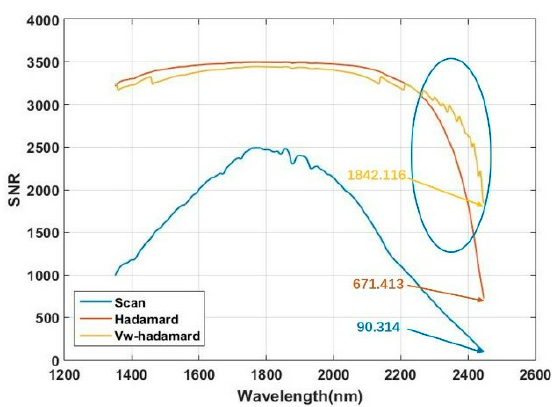
Figure 14. SNR of the spectrometer with the order of 227.